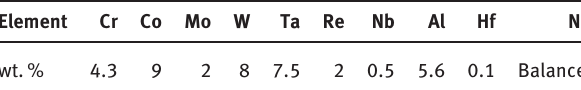
Table 1: Nominal composition of superalloy DD6 [27]. Element